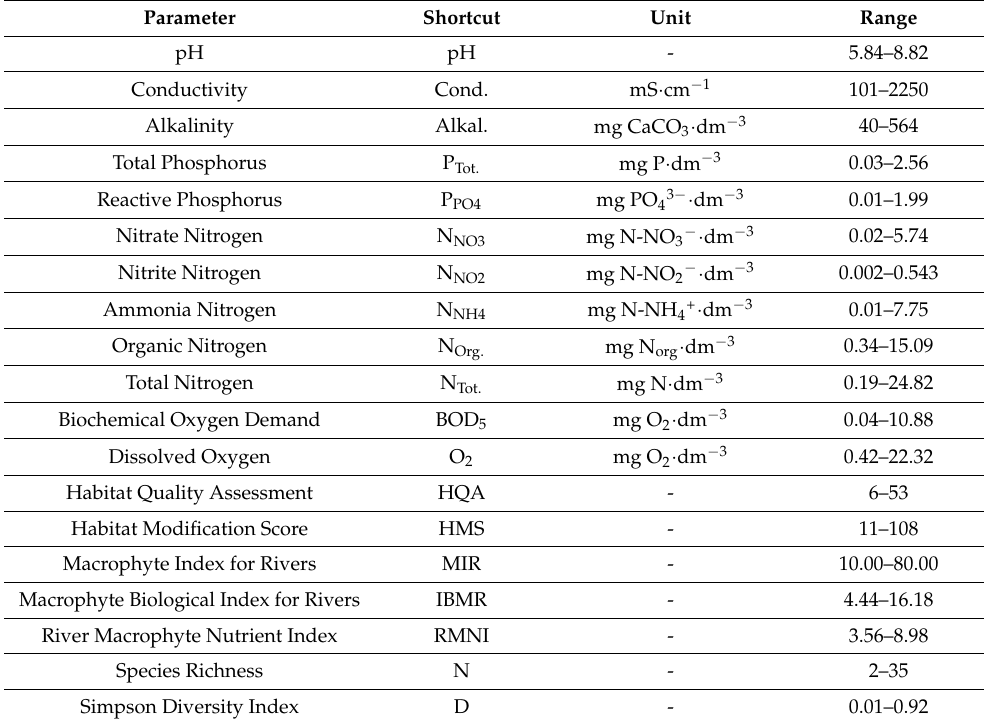
Table 1. The physicochemical parameters, hydromorphological indices, and macrophyte indices associated with their abbreviations, units, and ranges. Data from previous work